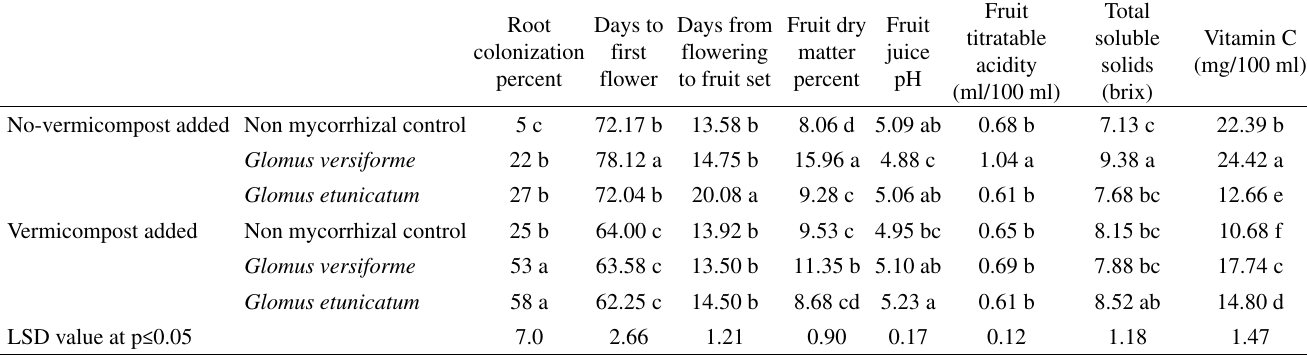
Table 5 - The interaction effects of vermicompost application and arbuscular mycorrhizal fungi inoculation on some pepino plant